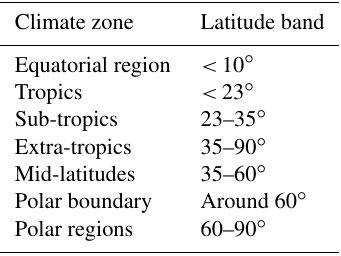
Table 1. The applied terms to describe latitudinal bands in this